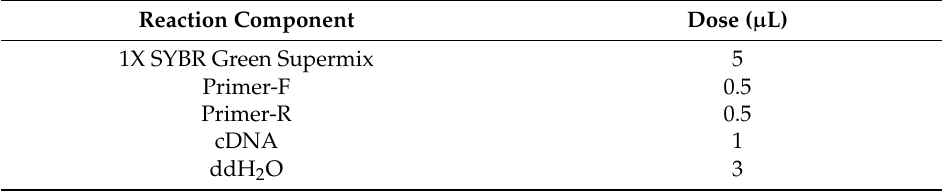
Table 5. The reaction system of qRT-PCR.